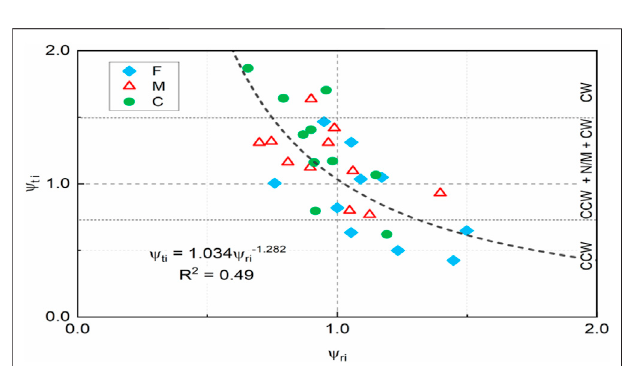
FIGURE 10 | Ratio of dimensionless reference shear stress for fi ne F , medium M and coarse C size classes in the rising limb over its counterpart in thefallinglimb( ψ ri )plottedasafunctionofthecorrespondingratiosde fi nedfor size-speci fi c bed load yields ( ψ ti